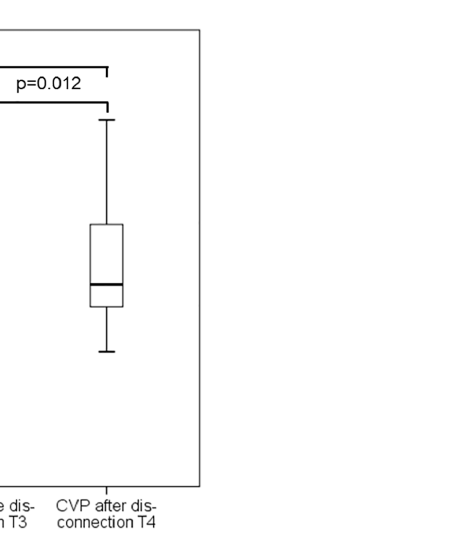
Fig 5. Boxplots comparing central venous pressure (CVP) values over time.